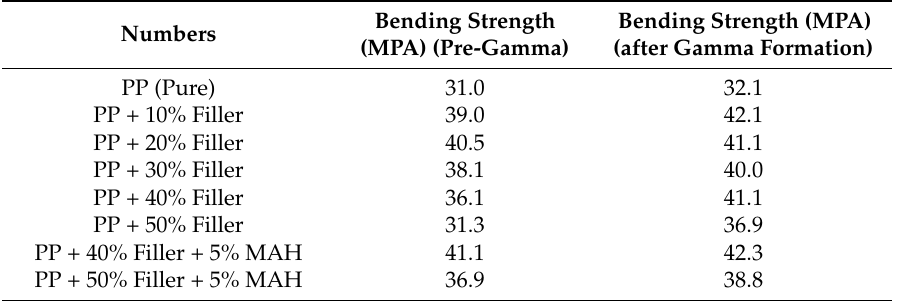
Table 6. Comparative presentation of bending strength findings for polypropylene matrix specimens before and after the radiation